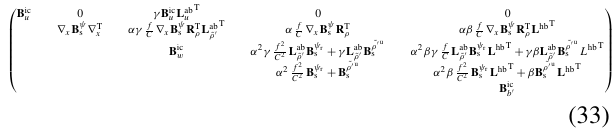
duces with higher vertical modes. This suggests that